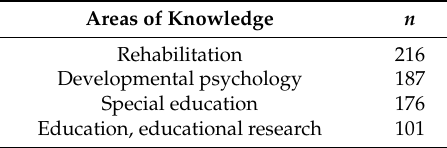
Table 4. Types of documents.